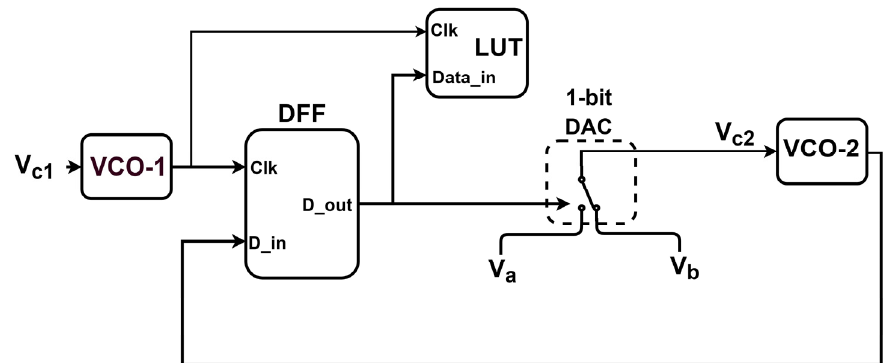
Figure 2. Equivalent circuit during Phase-I.